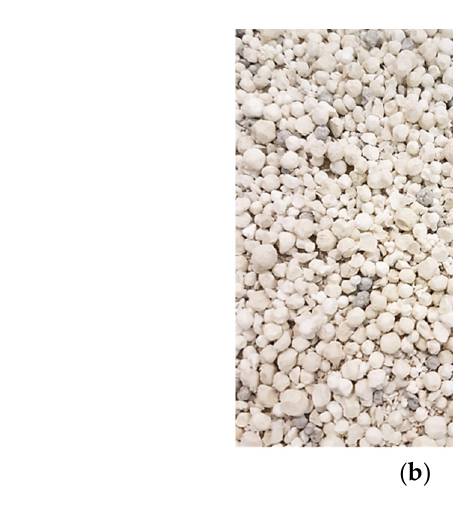
Figure 5. Lightweight aggregate examples ( a ) Cup plant stem and milled sieve fraction; ( b ) Expanded polystyrene aggregates (sieve fraction: 1–6 mm) [Scalebar = 1 cm].